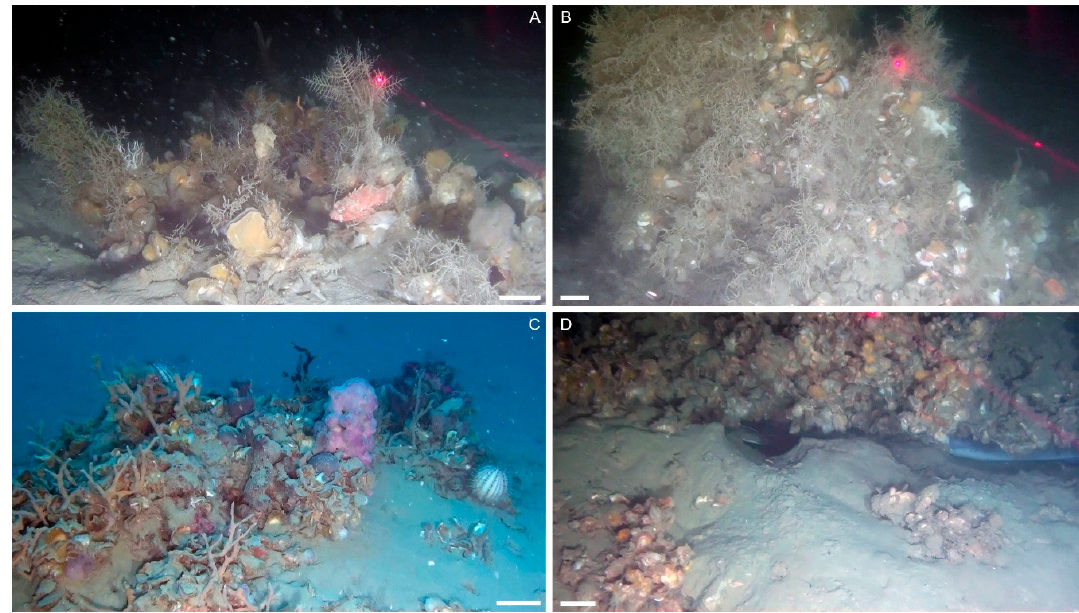
Figure 2. Different typologies of Neopycnodonte cochlear reefs on the Adriatic shelf. ( A ) Cluster of N. cochlear surrounded by muddy bottom, with hydrozoan turf and a juvenile Scorpaena scrofa , at ca. 80 m (Bonaccia); bar = 5 cm. ( B ) Close-up on an oyster-densely-packed Neopycnodonte cochlear reef (up to 3 m high) with a dense hydrozoan turf coverage at 80 m (Bonaccia); bar = 5 cm . ( C ) Neopycnodonte cochlear reef at 55 m (Vieste) showing intense oyster growth and the presence of the massive-globose cf. Petrosia sp. and the erected sponge Ulosa stuposa . The echinoid Echinus melo is a member of the associated vagrant fauna; bar = 10 cm. ( D ) Base of a Neopycnodonte cochlear reef at 75 m (Vieste) providing shelter to a large Conger conger individual; bar= 5 cm.